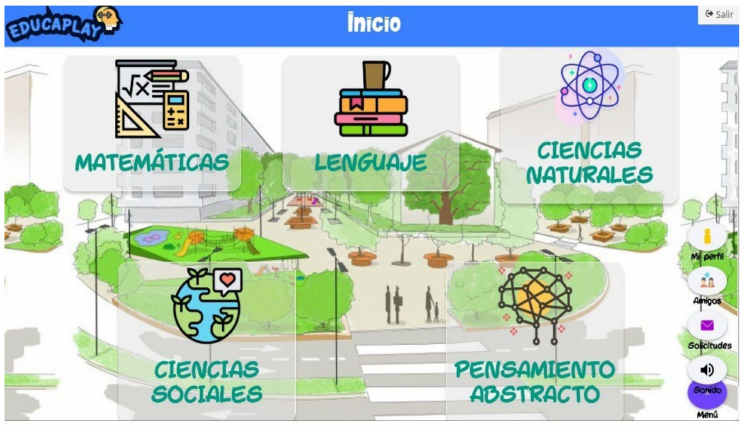
Figure 17. SG Fields of